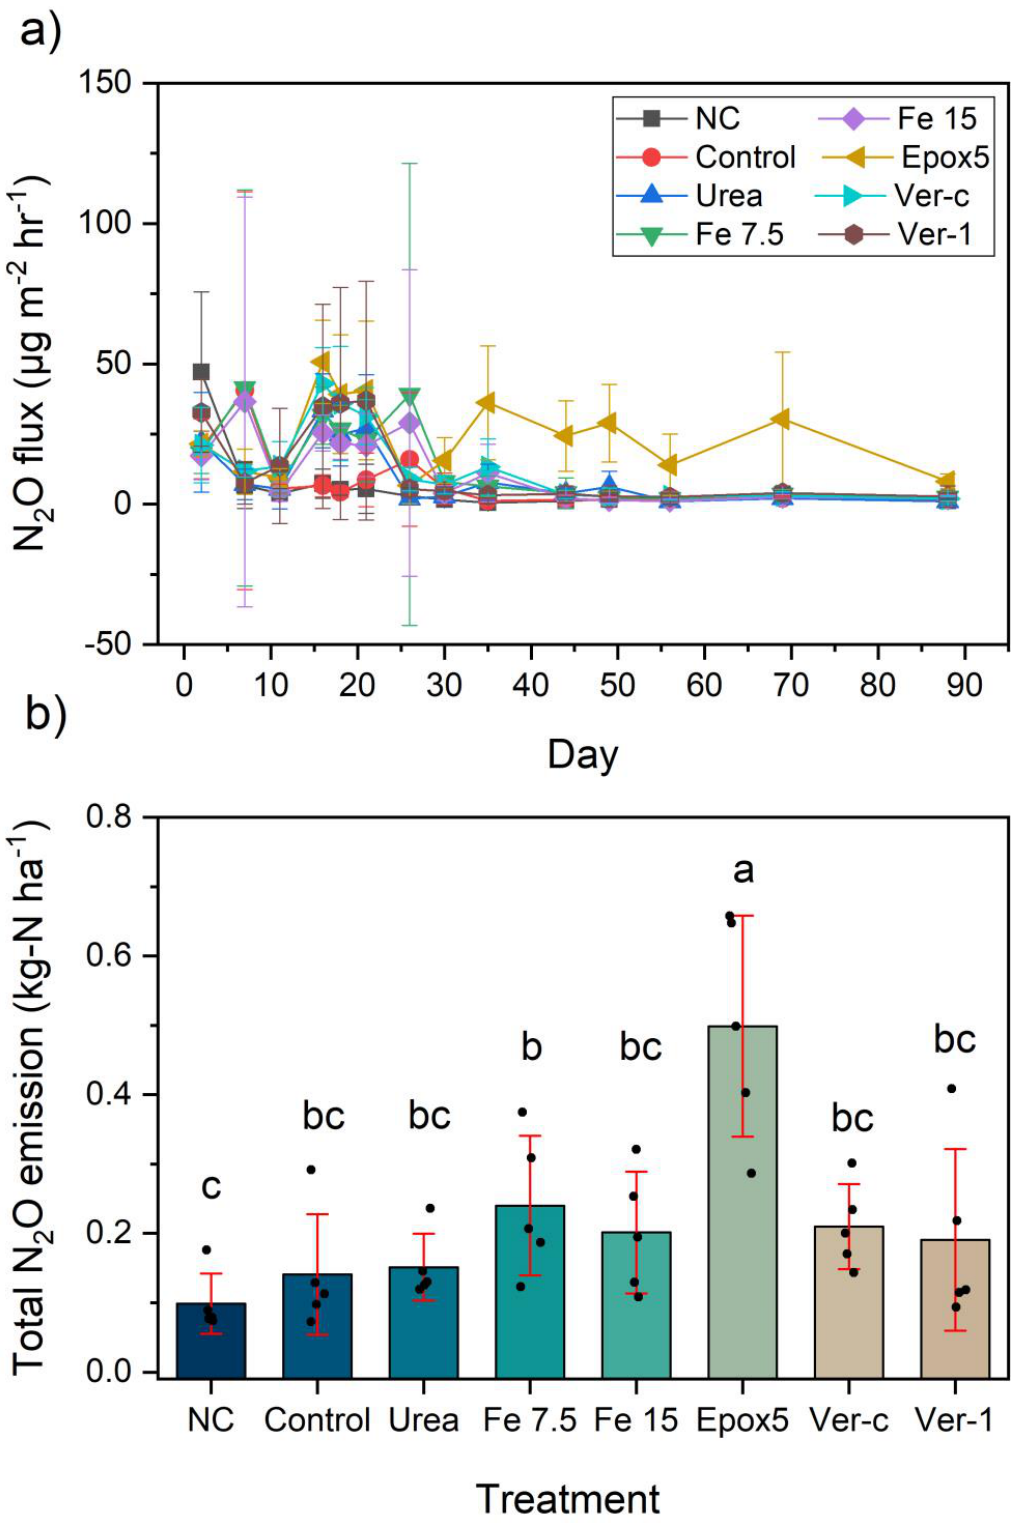
Figure 4. ( a ) The temporal variation of the N 2 O flux and ( b ) the bar chart with individual points comparing the total N 2 O emissions between treatments (error bars show the standard deviation and letters show a significant difference at p < 0.05 ( n = 5)).